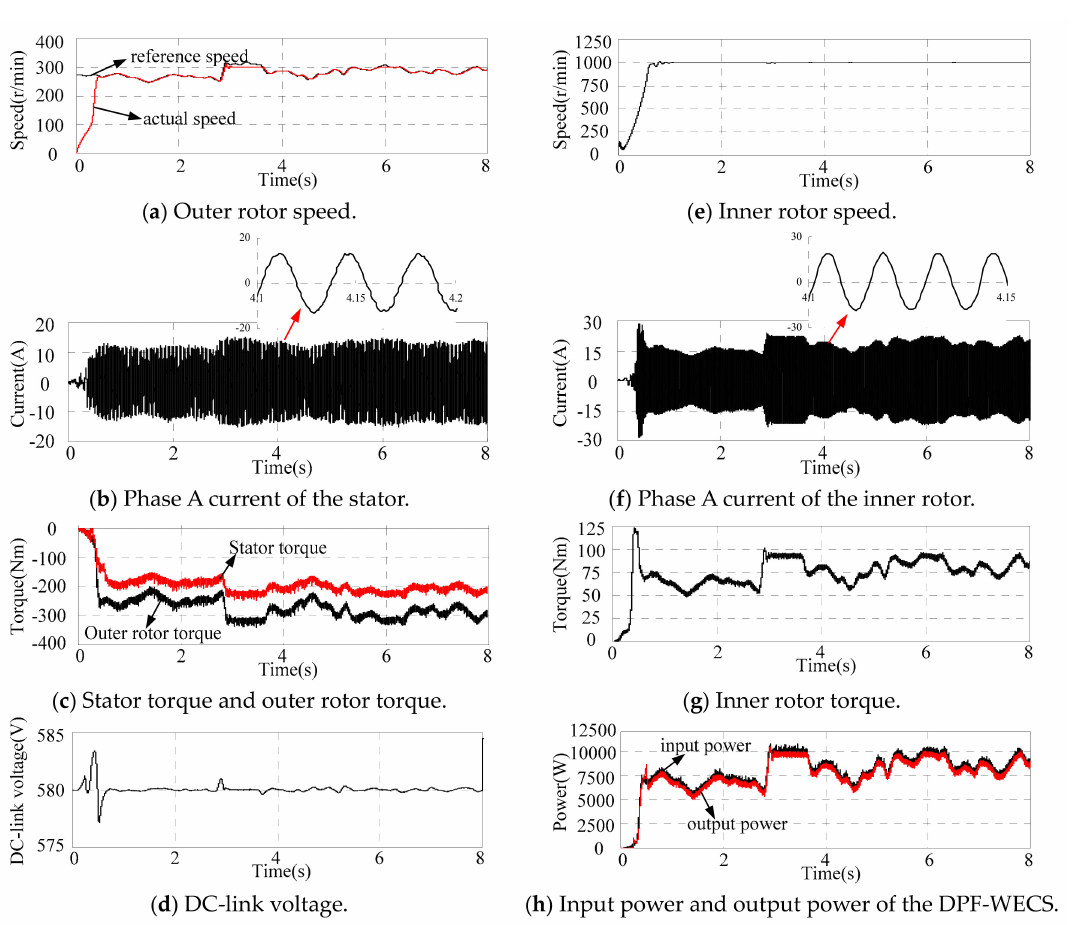
Figure 7. Simulation results of the